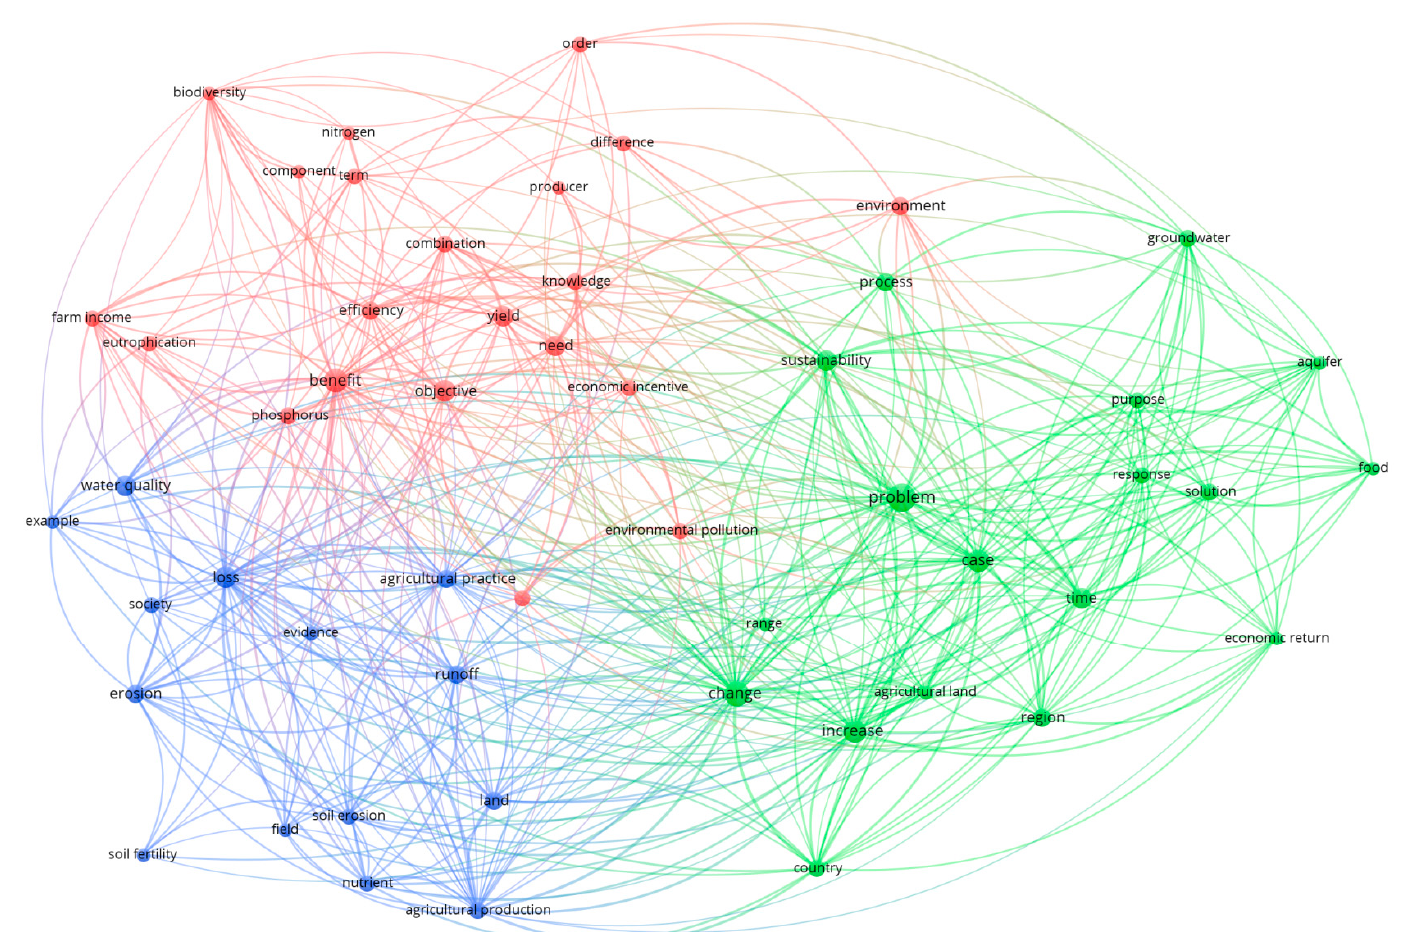
Figure 1. Map based on text data for 45 studies related with the topics: soil pollution and agricultural economics.